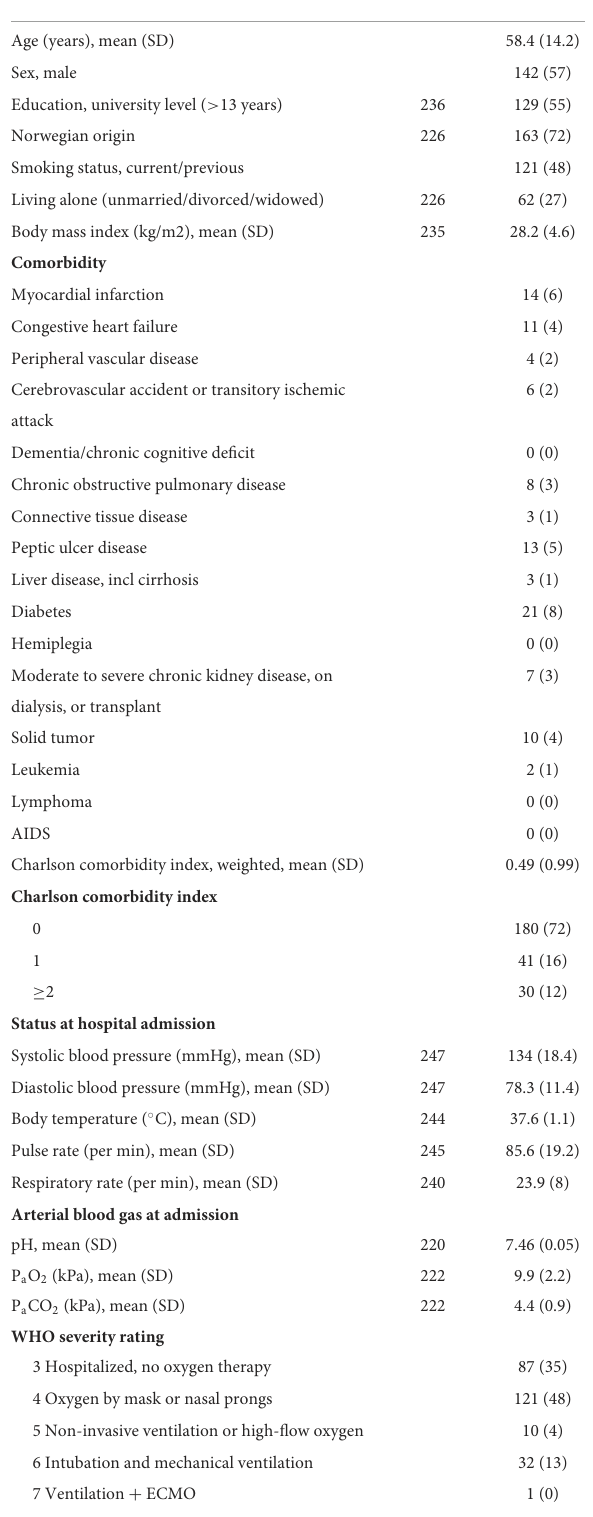
TABLE 1 Descriptive statistics for respondents ( N = 251), number (%) unless otherwise